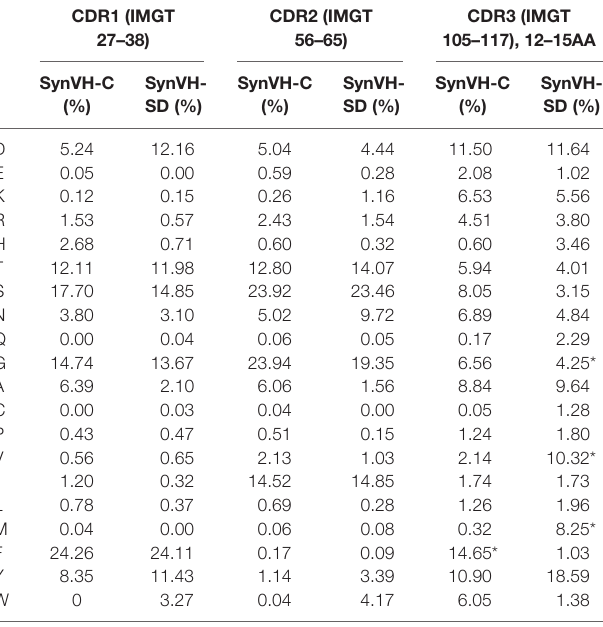
Table 4 | Amino acid distributions in CDRs